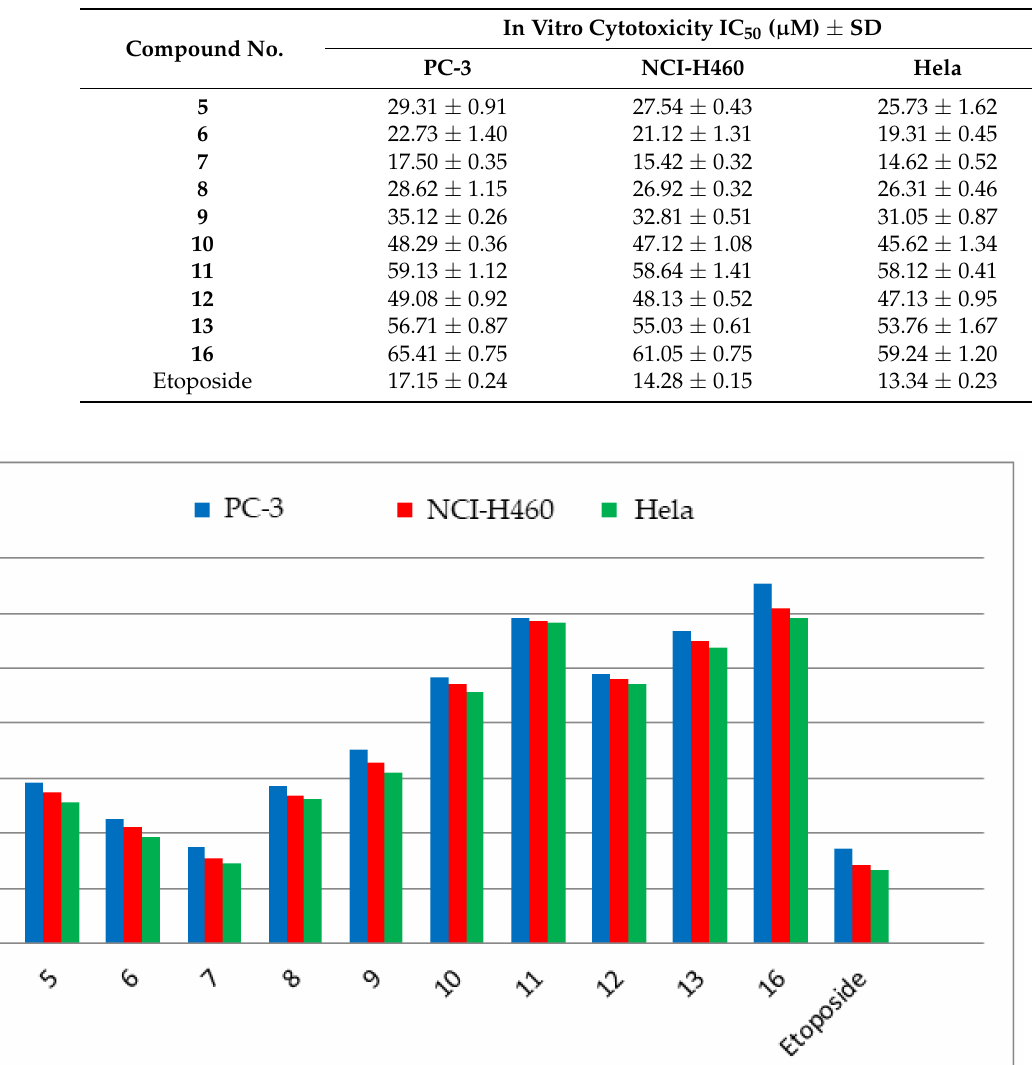
Table 1. In vitro cytotoxic results of the target compounds 5 – 13 , 16 and etoposide towards PC-3, NCI-H460 and Hela cell lines.